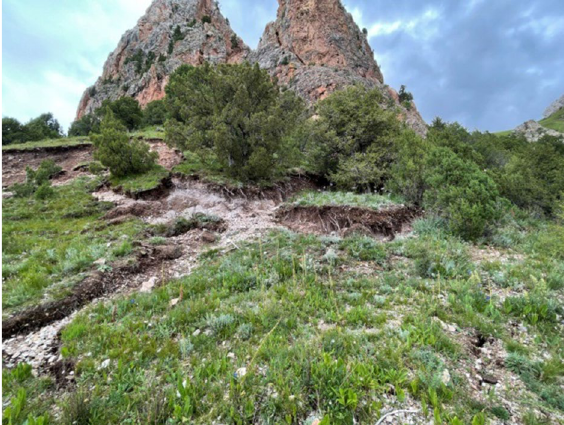
Figure 5. Landslide tensile cracks (2021.08).